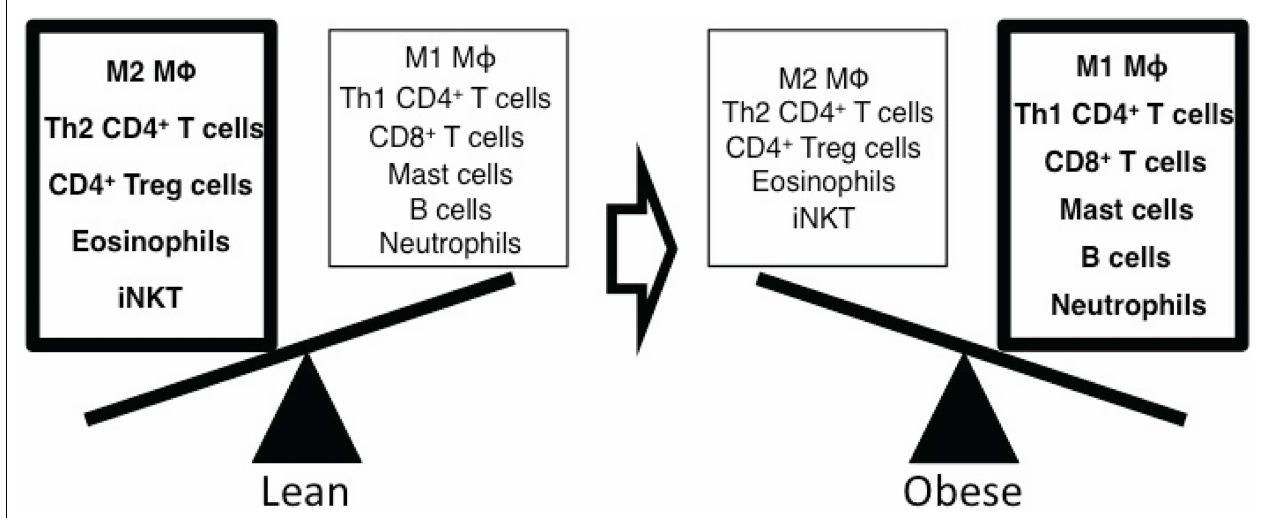
FIGURE 2 |Altered composition of immune cells with obesity regulates the inflammatory responses in adipose tissue . Alternatively activated M2 macrophages,Th2 CD4 + T cells, regulatory CD4 + T cells (T reg ), eosinophils, and iNKT cells are dominant immune cells in adipose tissue of lean mice.These cells secrete anti-inflammatory cytokines such as IL-4 and IL-10 to suppress inflammation and maintain insulin